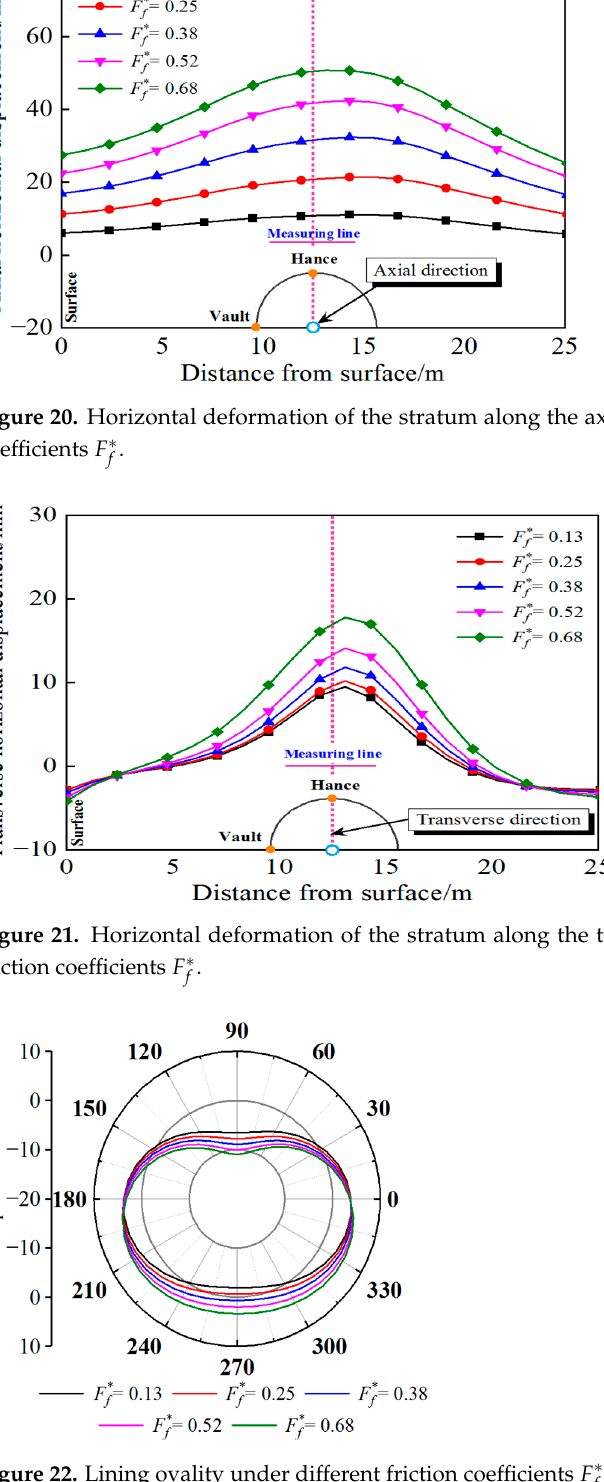
Figure 22. Lining ovality under different friction coefficients